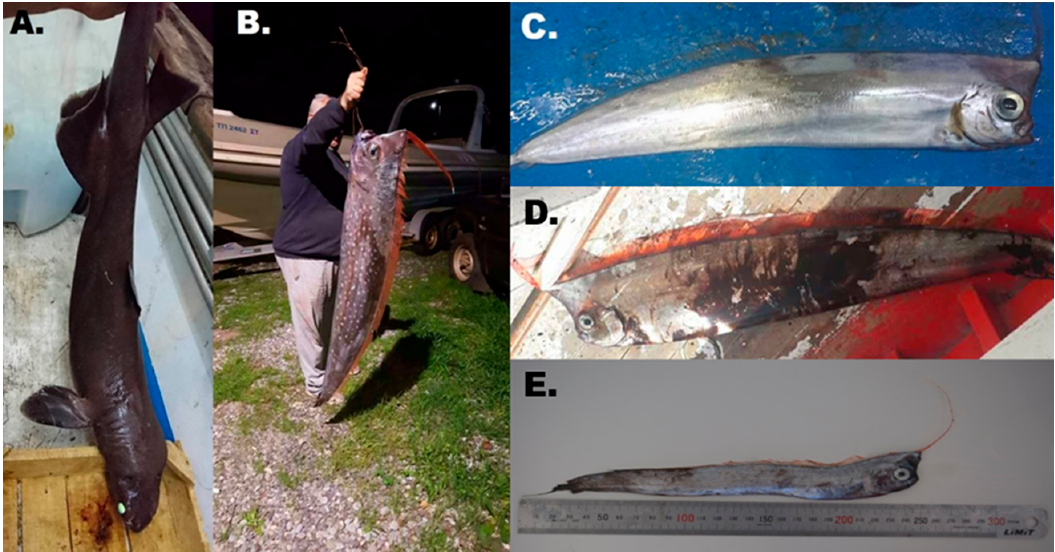
Figure 2. ( A ): Male Dalatias licha caught with demersal longlines off Amorgos Island, Greece; ( B ): L. lacepede caught with demersal longlines between Skopelos and Euboea Islands, Greece; ( C ): L. lacepede caught with demersal longlines between Santorini and Anafi Islands, Greece; and, ( D ): L. lacepede caught off the Coast of Chalkidiki Peninsula, Greece; ( E ): L. lacepede , Rhodes Island, Greece.